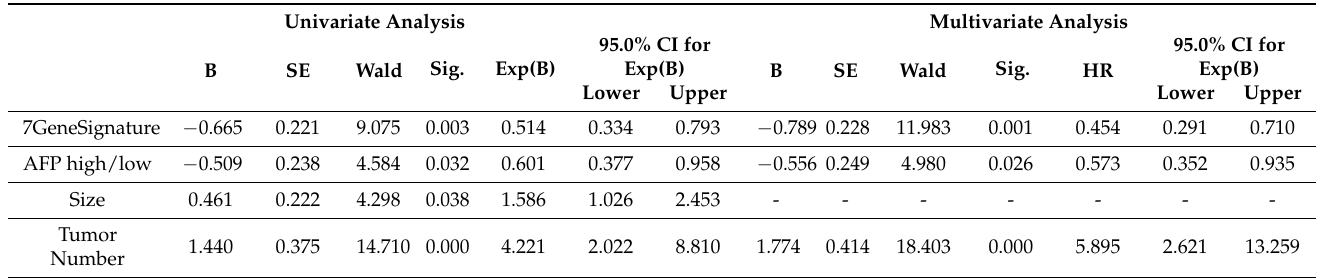
Table 3. Cox Regression Analysis for disease free survival (Discovery cohort).